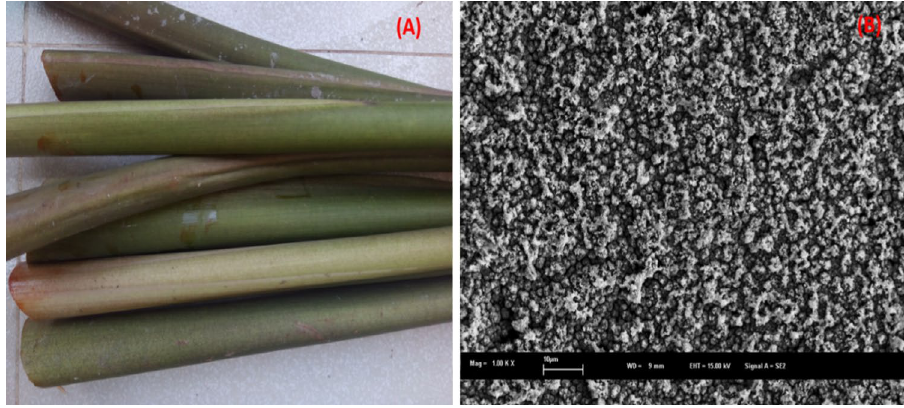
Fig. 6 Image of taro stem ( A ) and SEM image of taro carbon ( B